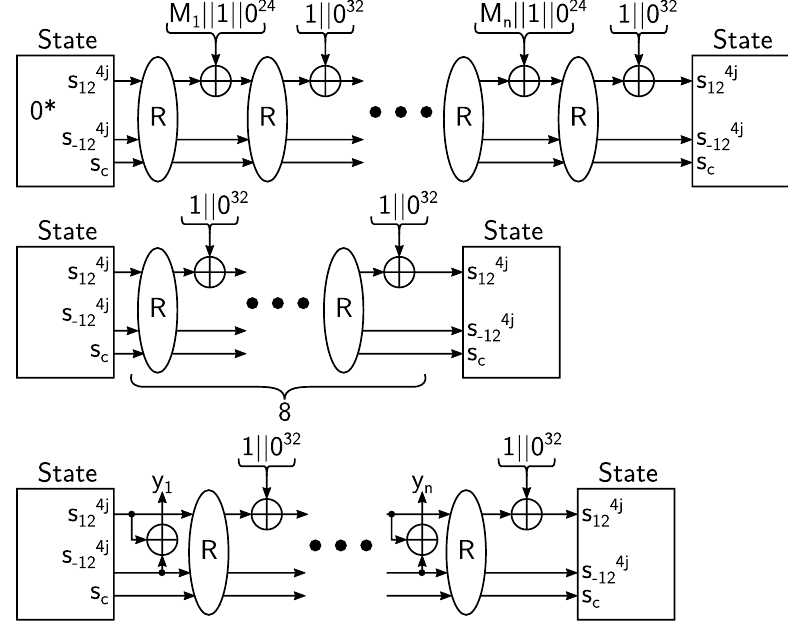
Figure 11: Subterranean